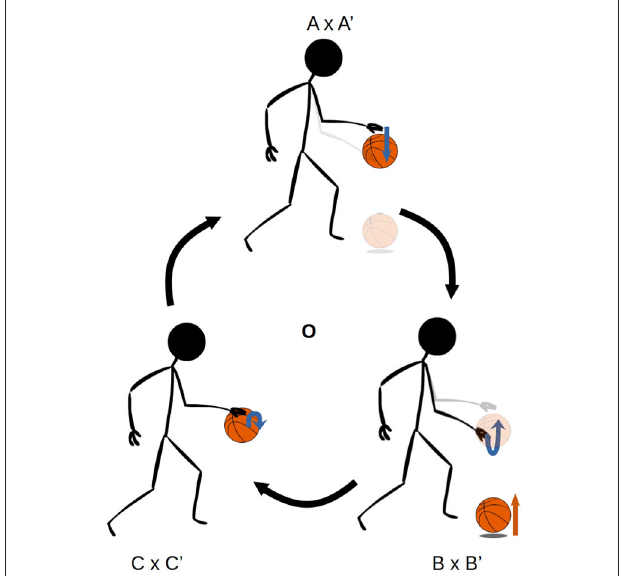
FIGURE 1 | The sensorimotor scheme O , associated with the behavior of bouncing a basketball. The scheme consists of the cyclical organization of the three coordinations, A × A’ → B × B’ → C × C’ → A × A’, where the arrows indicate the transitional structure between these coordinations. The A × A’ notation refers to the simultaneous realization of the agent-side sensorimotor support structure A, and the environment-side response structure